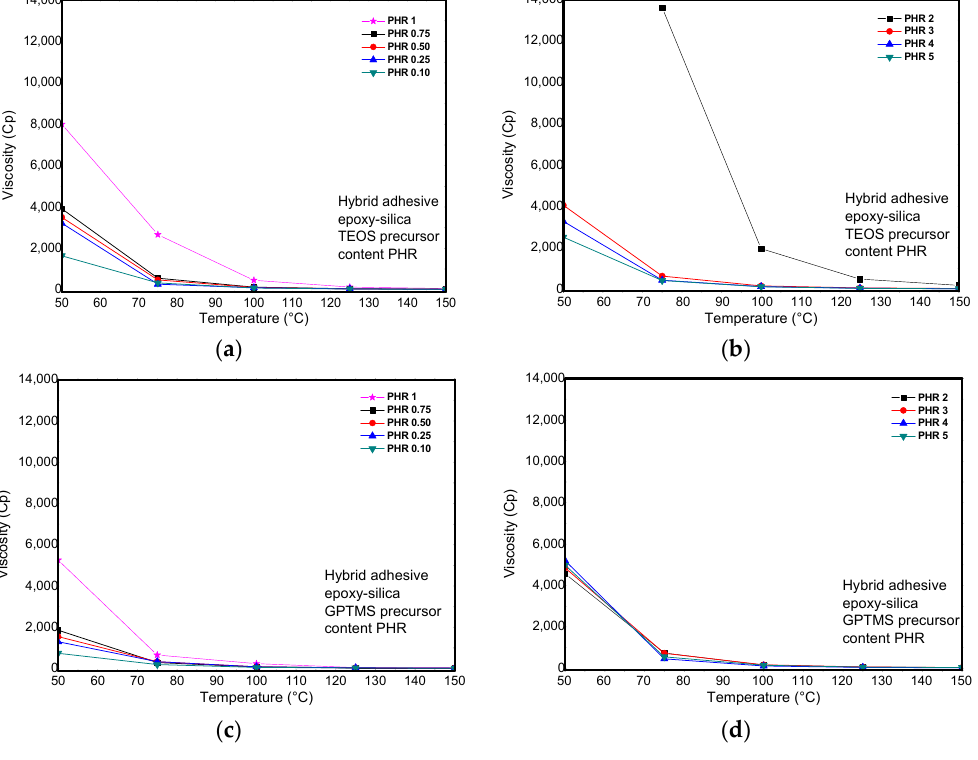
Figure 4. Viscosity of the epoxy-sílica matrix synthesized in situ varying the content of different inorganic precursors: ( a , b ) TEOS precursor; ( c , d ) GPTMS precursor.